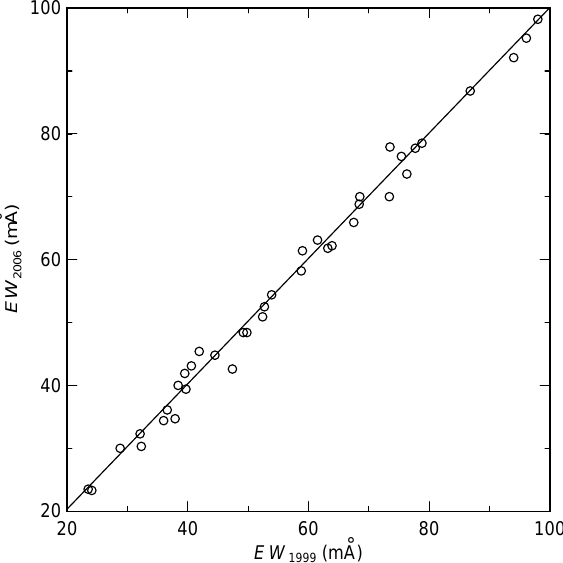
Fig. 1. A comparison of the equivalent widths measured in the 33 Psc spectra observed in 1999 and